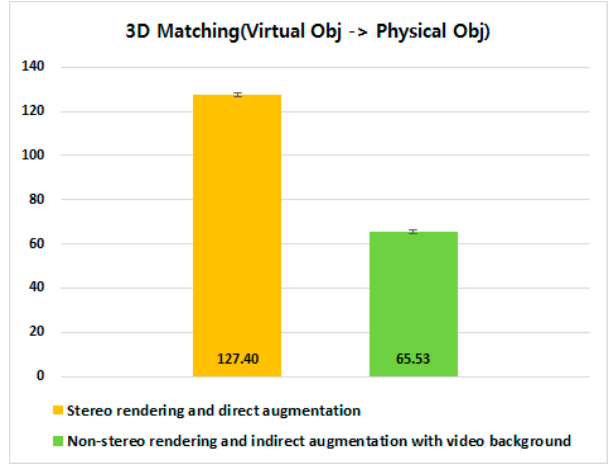
Figure 22. Task completion time (s) for 3D matching.